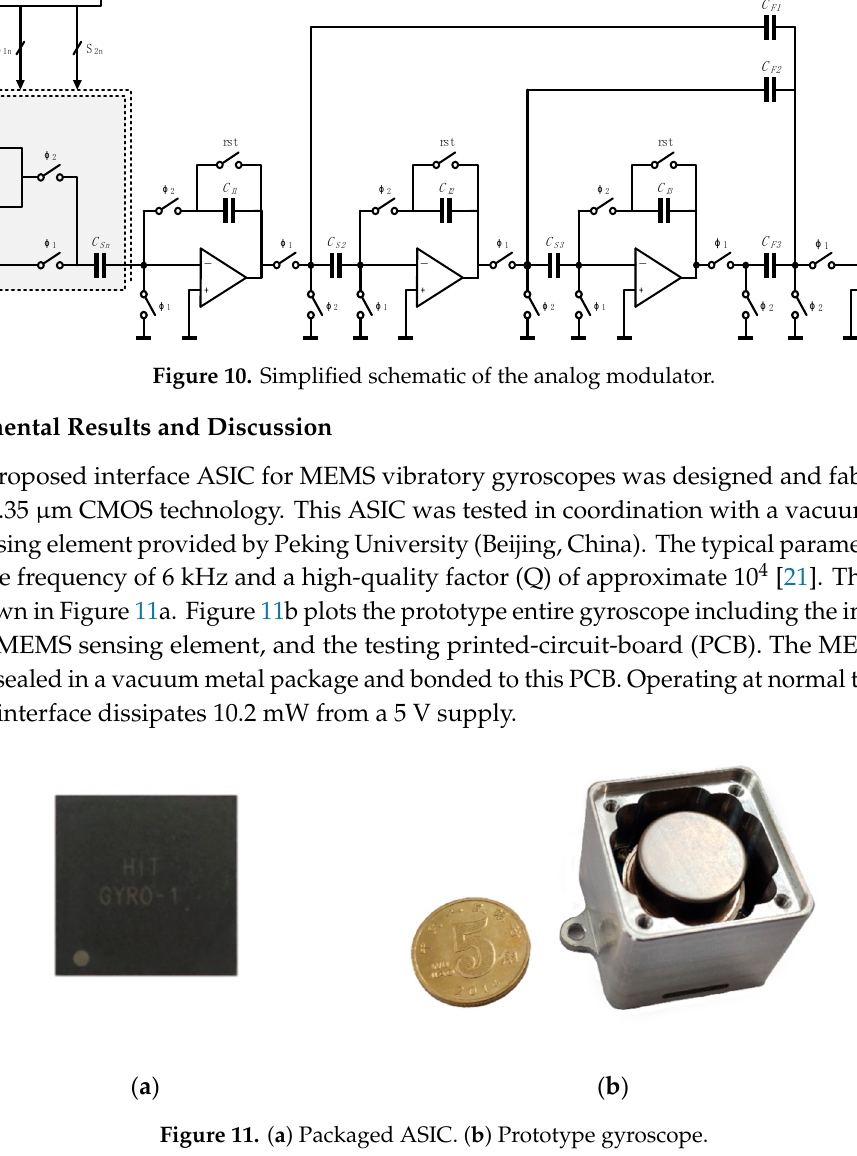
Figure 11. ( a ) Packaged ASIC. ( b ) Prototype gyroscope.